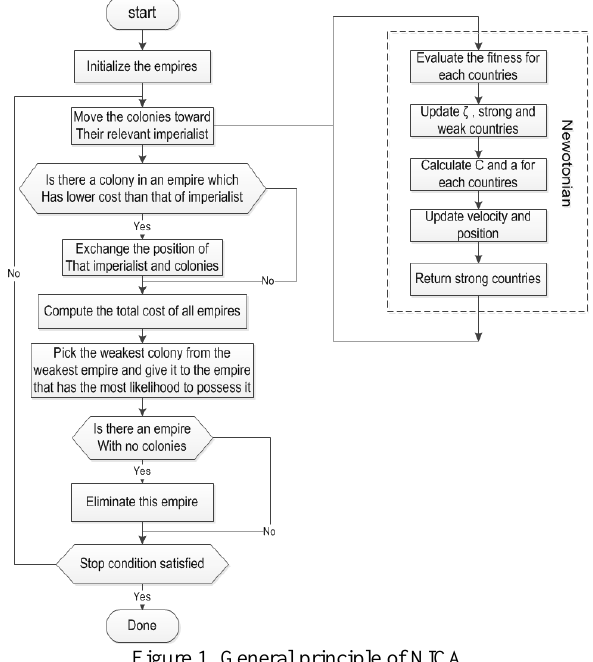
Figure 1. General principle of NICA